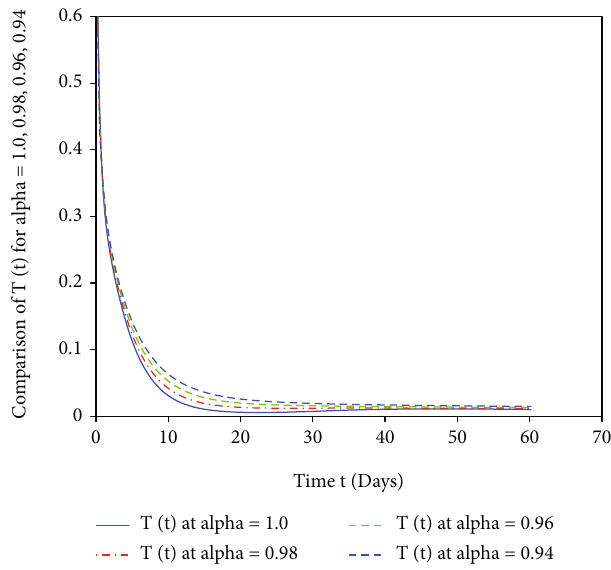
Figure 8: Chronically infected treated class T ð t Þ for ϱ = 1 : 0, 0 : 98, 0 : 96, 0 : 94